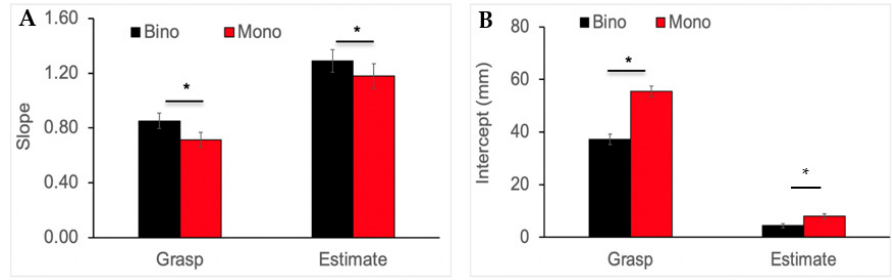
Figure 4. Mean slope ( A ) and intercept ( B ) values from a regression analysis relating grip aperture and object size for grasping and estimation tasks across the viewing conditions. Error bars show ±1 standard error. The slope was significantly lower, and the intercept was significantly higher for the grasping in comparison to the estimation task. Monocular viewing was associated with lower slope and a higher intercept for both tasks (* p < 0.05).